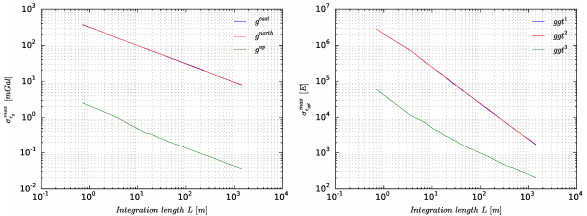
Figure 10: Effect of the AUV attitude uncertainty. Vertical com- ponent g U is less affected than horizontal components g E and g N . Despite the low-pass filtering, uncertainties affecting the components of the gravity gradient tensor are still high when compared to the gravity effect of geological sources.